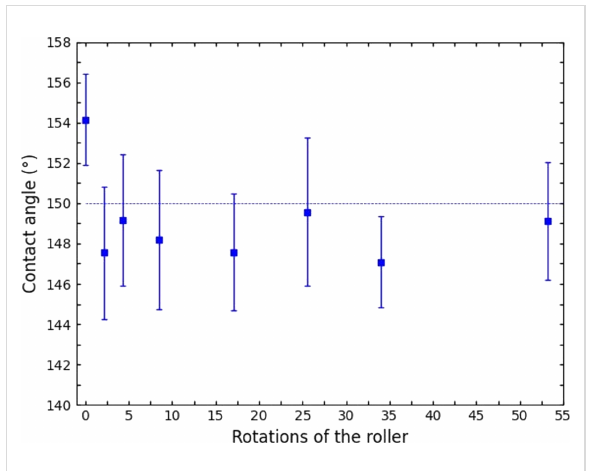
Figure 5: Contact angles measured along a 25 m long foil of nanofur produced in the described roll-to-roll process. A reduction by about 4° is measured when the newly sandblasted roller is first covered in fresh residues. As long as the production process is not interrupted, no further decrease in contact angle